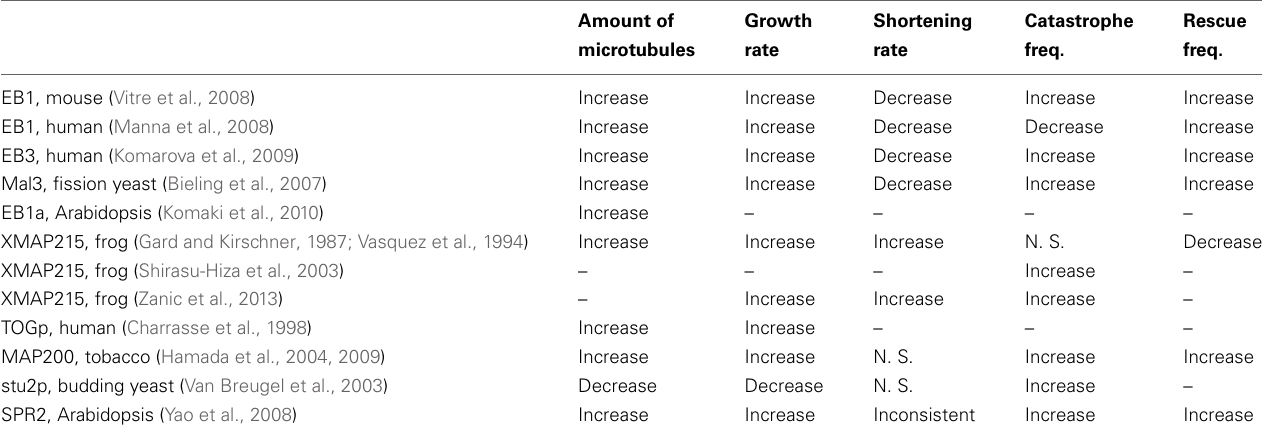
Table 4 | Effects of microtubule dynamics promoters on microtubule